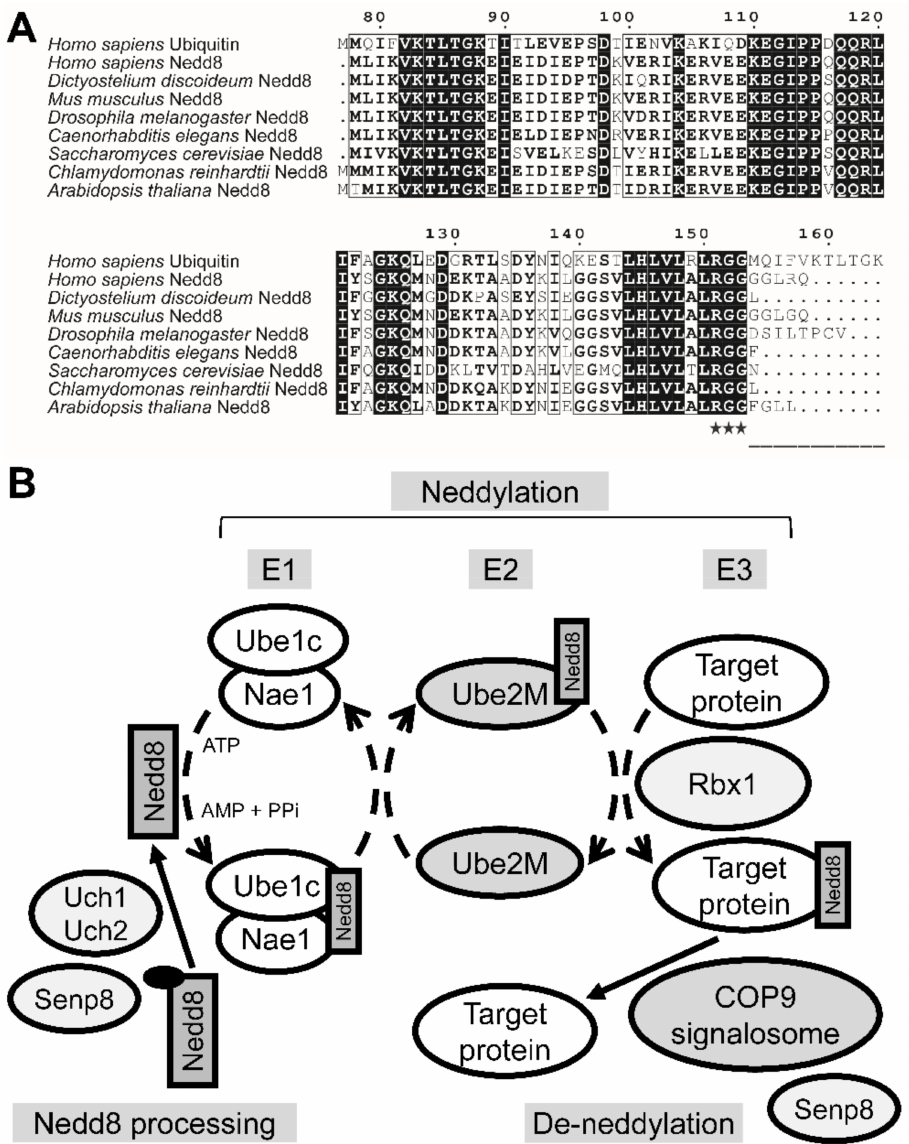
Figure 1. The putative neddylation pathway in Dictyostelium discoideum. ( A ) The D. discoideum neural precursor cell expressed developmentally downregulated protein 8 (Nedd8) is highly conserved and contains a single residue C-terminal extension. Alignments between human polyubiquitin C (P0CG48, Uniprot), human NEDD8 (Q15843, Uniprot), and NEDD8 orthologs in representative species ( Mus musculus , P29595, Uniprot; Drosophila melanogaster , Q9VJ33, Uniprot; Caenorhabditis elegans , Q93725, Uniprot; Saccharomyces cerevisiae , Q03919, Uniprot; Dictyostelium discoideum , Q54XV3, Uniprot; Chlamydomonas reinhardtii , A8IZZ4, Uniprot; and Arabidopsis thaliana , Q9SHE7, Uniprot) were compiled and aligned using the MUSCLE alignment tool available on MEGAX. The sequence position number corresponds to the region of human ubiquitin that aligns to NEDD8. The RGG motif for NEDD8 conjugation is marked by stars. The C-terminal extension for NEDD8 and orthologous sequences is underlined. Sequence similarity is depicted in terms of % equivalent for the colouring scheme. The alignment display was generated using the ESPRIPT 3.0 tool. ( B ) The proposed model showing how Nedd8 is conjugated to target proteins in D. discoideum . Nedd8 is translated as an inactive protein with a C-terminal extension (black oval) that is cleaved by ubiquitin C-terminal hydrolase 1 and 2 (Uch1 and Uch2, respectively) and sentrin-specific protease 8 (Senp8) to generate the mature Nedd8 protein, which is then transferred through an E1–E2–E3-like cascade to a target protein via ubiquitin-activating enzyme E1C (Ube1C), Nedd8-activating enzyme E1 (Nae1), ubiquitin-conjugating enzyme E2 M (Ube2M), and the E3 ubiquitin protein ligase Rbx1. De-neddylation is carried out by the constitutive photomorphogenesis 9 (COP9) signalosome. Senp8 also contributes to de-neddylation but is not essential to the